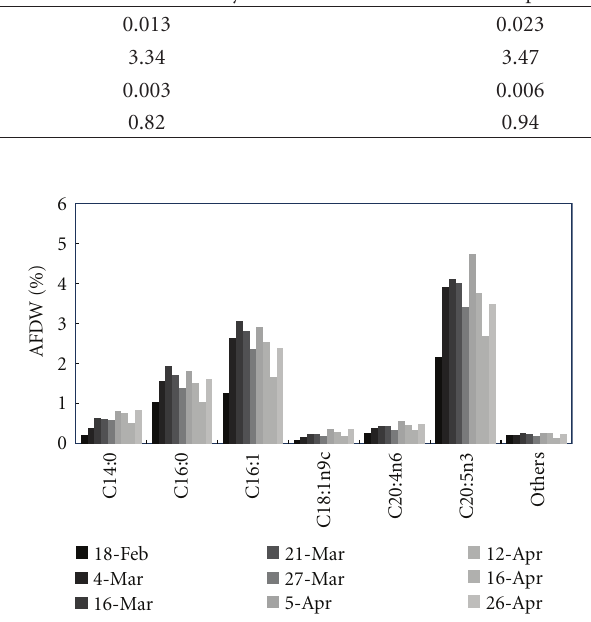
Table 2: ARID and conventional raceway biomass and lipid productivity. Conventional raceways ARID pond